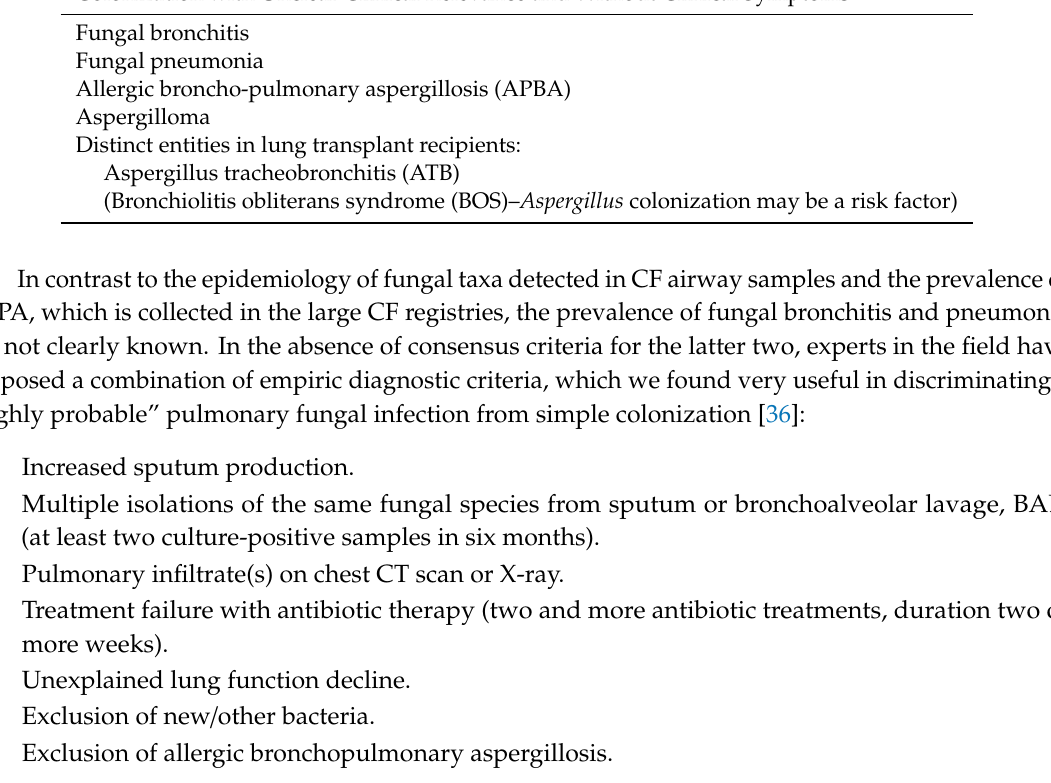
Table 2. Respiratory fungal conditions in cystic fibrosis (CF) lung disease and after lung transplantation. Colonization with Unclear Clinical Relevance and Without Clinical